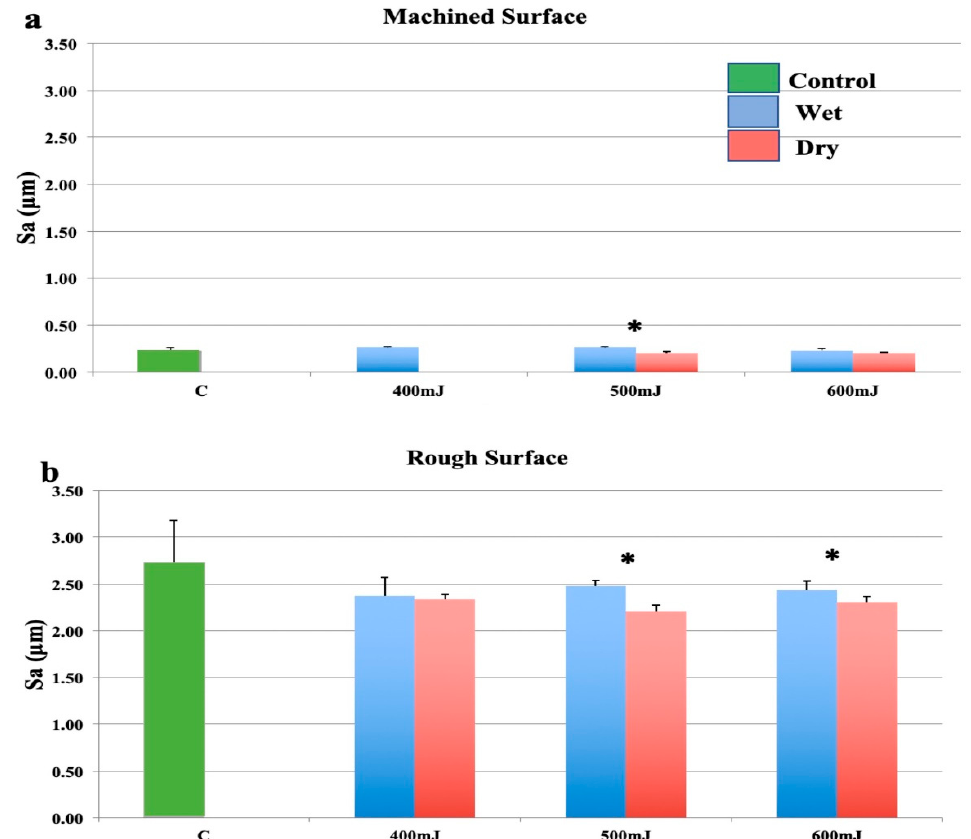
Figure 2. Effects of the erbium: yttrium aluminium garnet (Er:YAG) laser with a plain fibre tip held in a 2062 handpiece. ( a ): Machined surfaces. ( b ): Roughened surfaces. Bars show controls (green), wet surfaces (blue), and dry surfaces (red). * indicates a significant difference between wet and dry conditions ( p < 0.05).